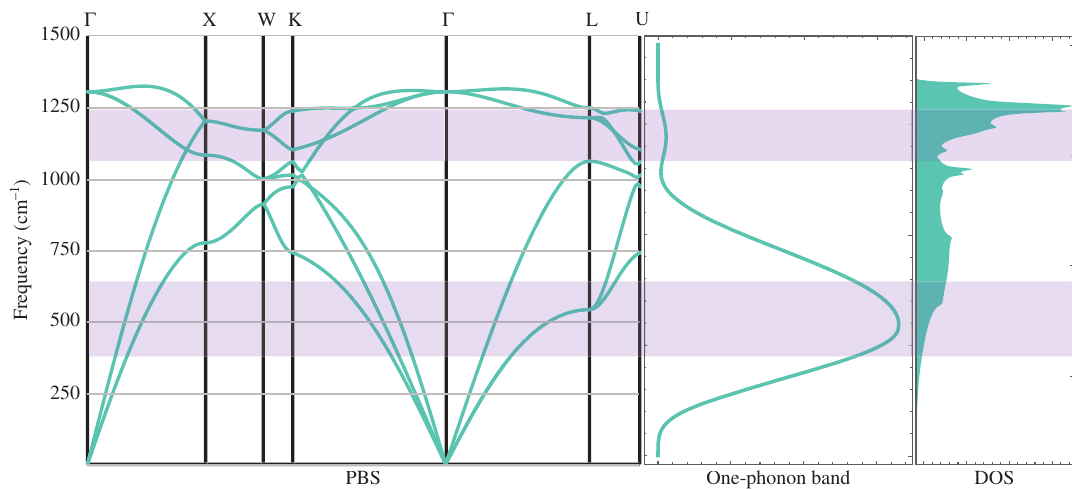
Figure 6: The comparison of the one-phonon band with the DOS and PBS of pristine diamond [14]. The shaded areas connect adjacent points to highlight regions of interest.